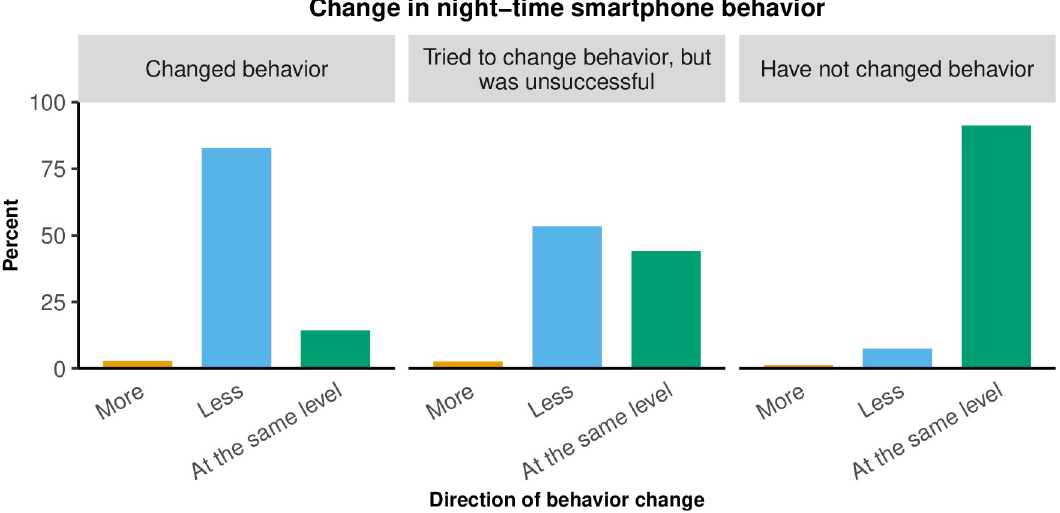
Fig 2. Change in night-time smartphone behavior according to the direction of change among 4,926 participants who used their smartphone during sleep hours at baseline.